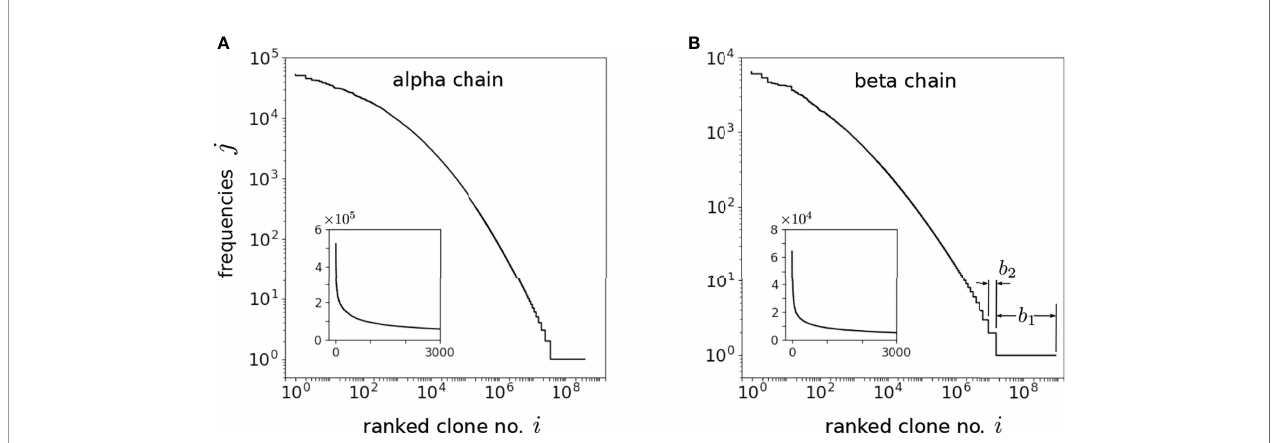
FIGURE 5 | Ordered integer-valued frequencies j , plotted on a log-log scale, of the C distinct (A) alpha and (B) beta chains drawn using OLGA. The index 1 ≤ i ≤ * C * < N * labels the distinct sequences drawn while b j is de fi ned as the number these sequences that exhibit the speci fi c frequency j [ b 1 and b 2 are explicitly indicated is comparable to N , the drawn sequences are dominated by the low probability in (B) ]. The highest frequency clone appears J times such that b j>J = 0. Since C * * ones that appear only once. The insets display the frequencies on a linear scale and indicate the long-tailed behavior of the frequencies. The shape of the frequency ≳ 10 7 , allowing us to use this sampling procedure to reliably estimate p a ( a j (cid:2) a spectra is self-similar once N *